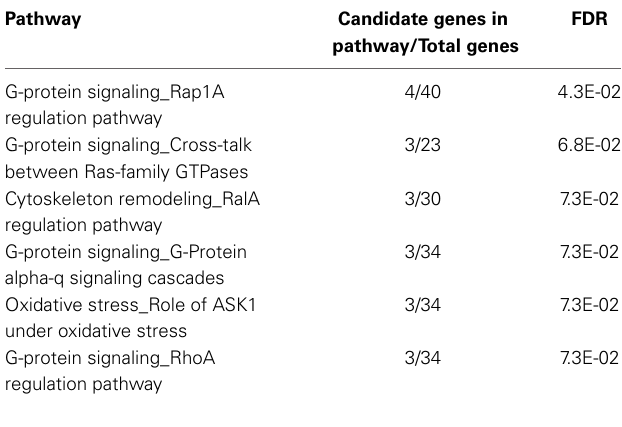
Table 1 | Pathway enrichment analysis for combined set of candidate genes.